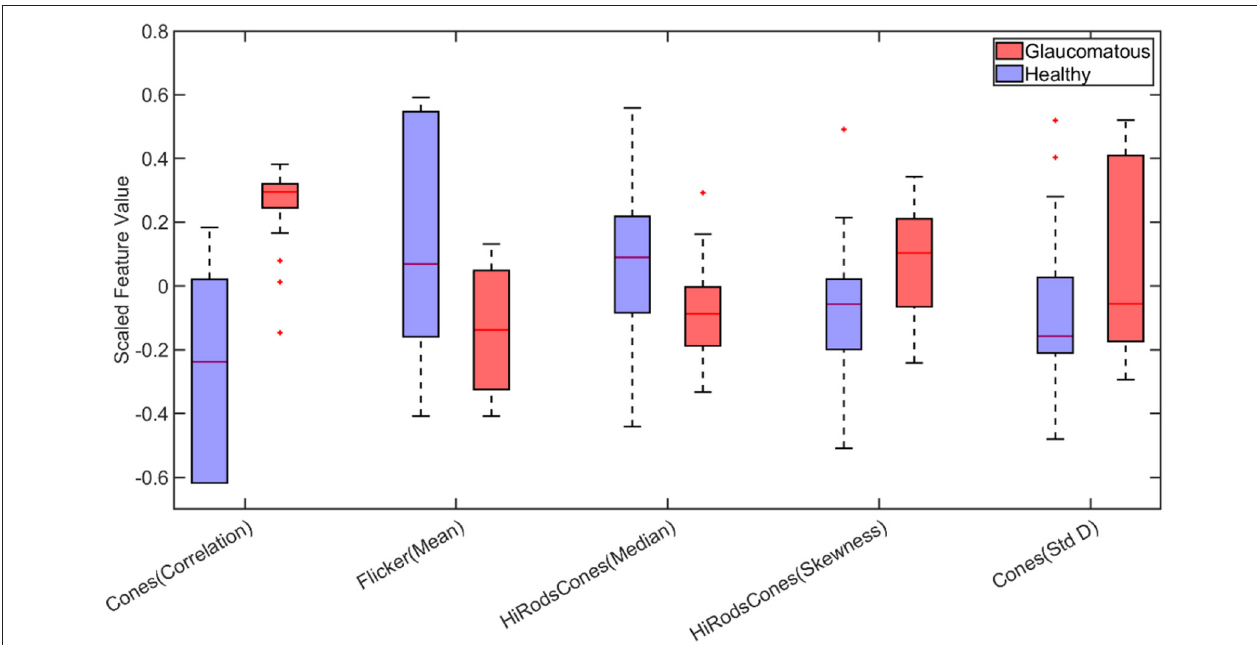
FIGURE 4 | Boxplot of statistical features selected by Minimum Redundancy and Maximum Relevance (MRMR) feature selection algorithm for binary classification (Std D, Standard Deviation). On each box, the central mark indicates the median, and the bottom and top edges of the box indicate the 25th and 75th percentiles, respectively. The whiskers extend to the most extreme data points not considered outliers, and the outliers are plotted individually using the “+” marker symbol.